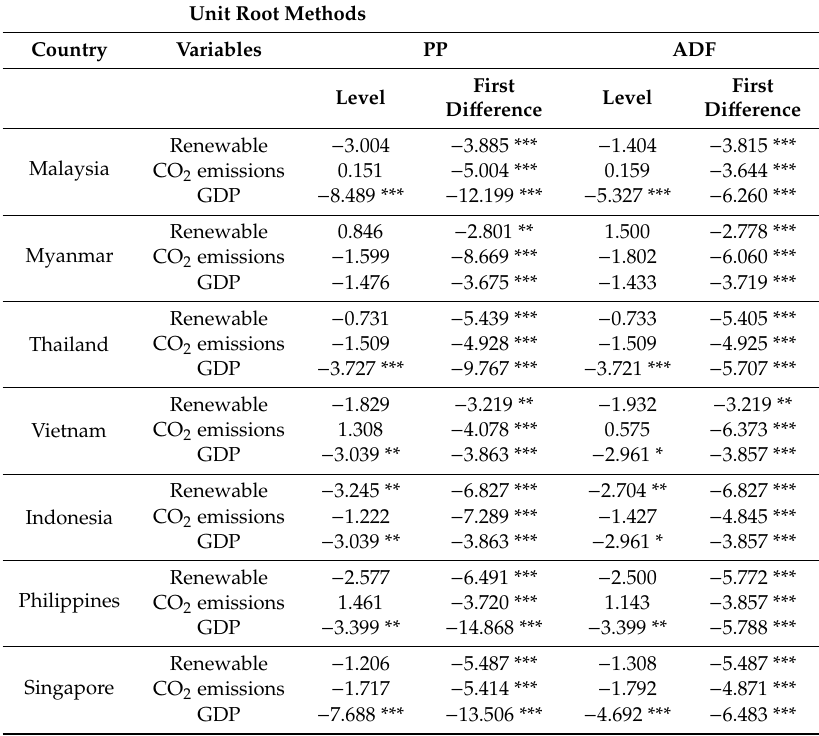
Table 3. Panel unit root test results for ASEAN